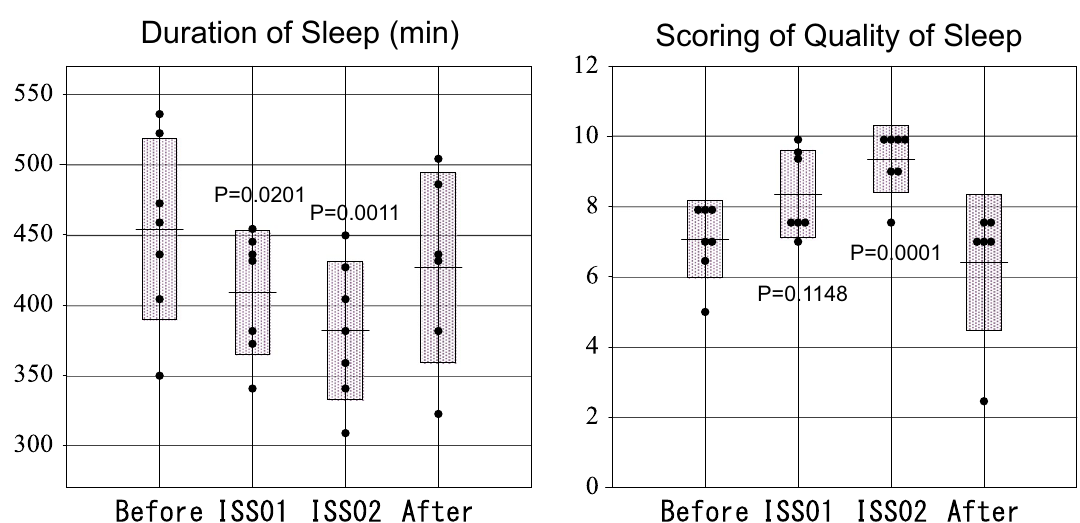
Figure 3. Changes in sleep duration (left) and quality of sleep score (right) in Group B astronauts. Sleep duration shortened from 454.0 ± 64.7 min (Before) to 408.9 ± 43.8 min (ISS01, P = 0.0201) and 381.6 ± 49.2 min (ISS02, P = 0.0011) during spaceflight, returning to 426.7 ± 67.5 min after the mission (left). Quality of sleep improved from 7.07 ± 1.10 to 8.36 ± 1.25 (ISS01, P = 0.1148) and 9.36 ± 0.95 (ISS02, P = 0.0001), returning to 6.42 ± 1.93 after return to Earth